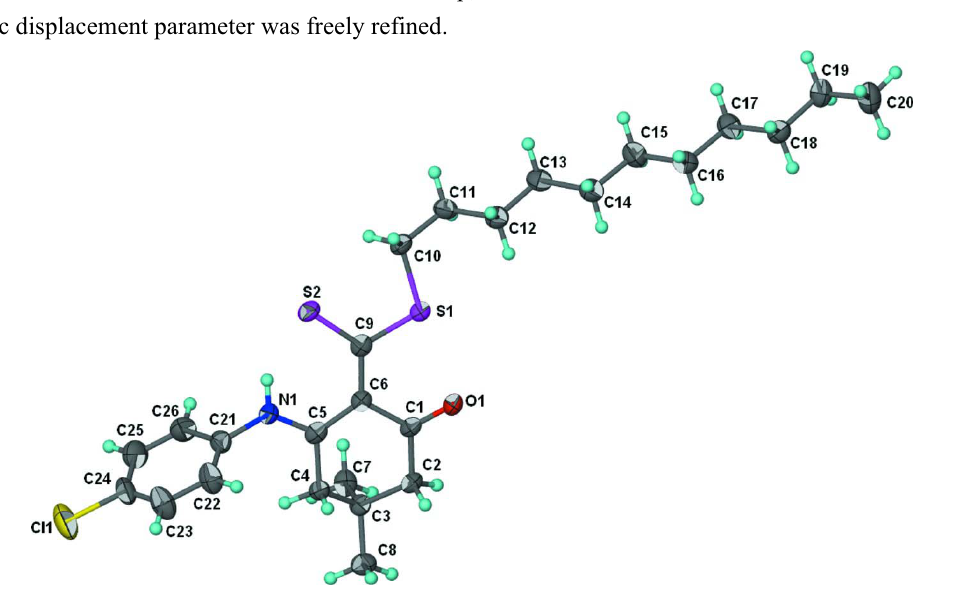
H ClNOS at the 70% probability level; hydrogen 26 38 2